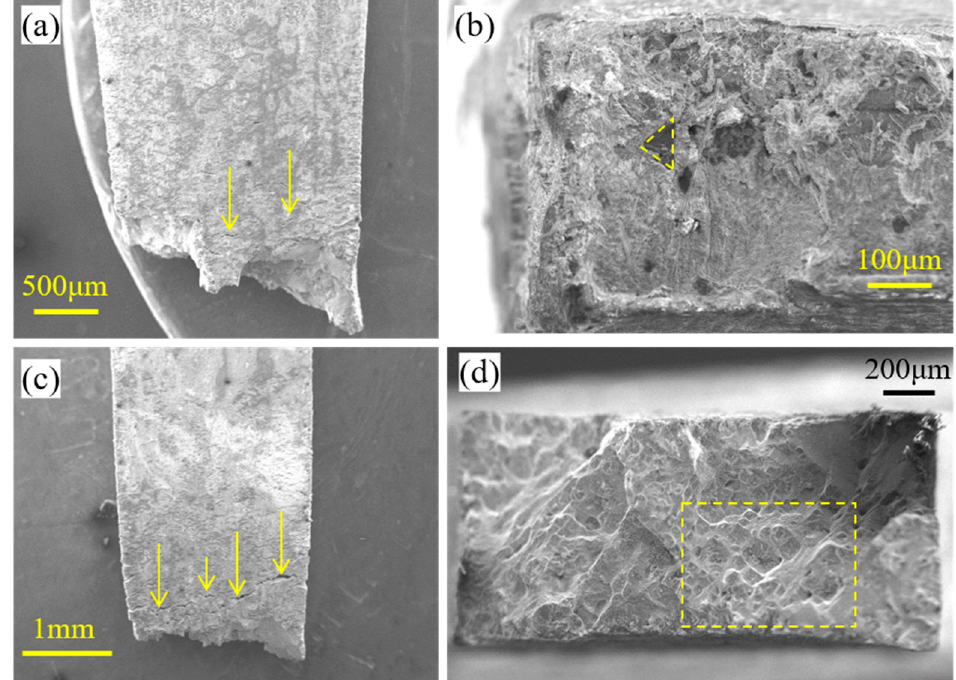
Figure 15. SEM observation of the rupture thin-walled specimens. ( a ) The region near the fracture surface of the 0.6 mm thick specimen reconstructed after rupture. ( b ) The fracture morphology of the left part of one half of the specimen in ( a ) (the loading direction is towards the viewed plane). ( c ) The region near the fracture surface of the 1.2 mm thick specimen reconstructed after rupture. ( d ) The fracture morphology of the left part of one half of the specimen in ( c ).